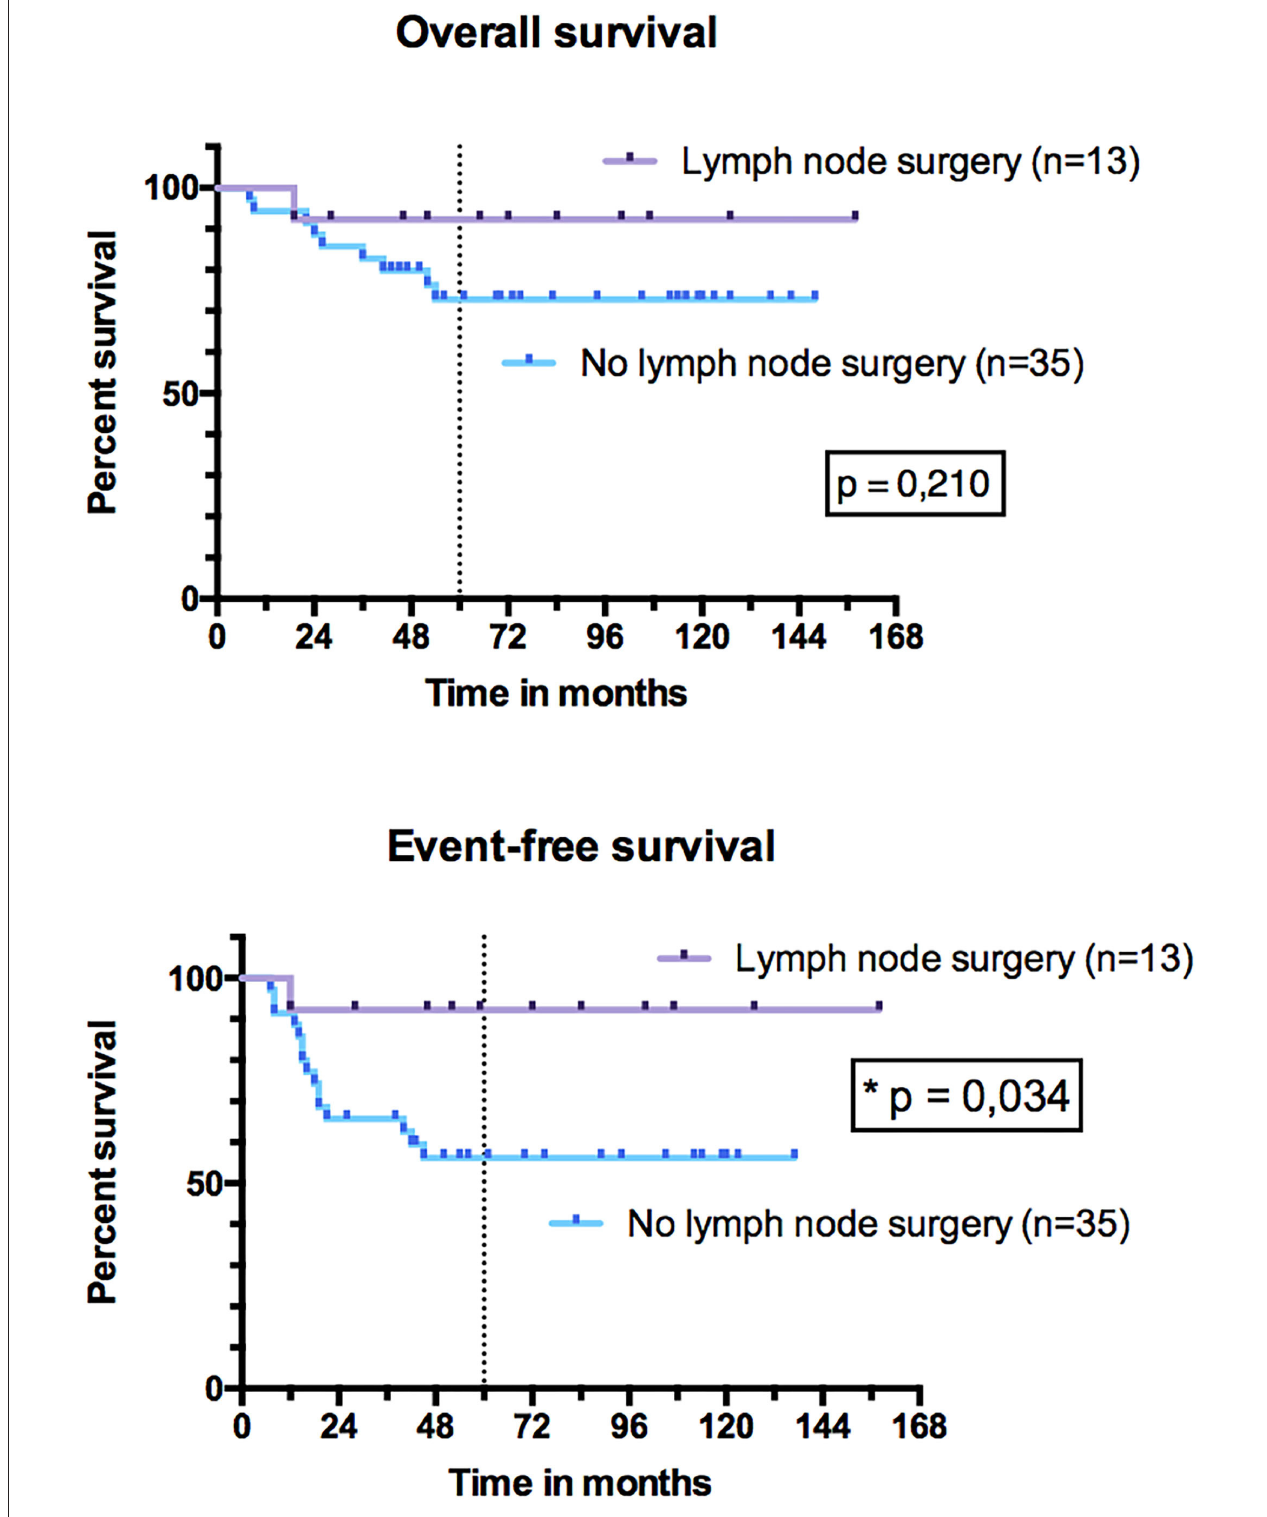
FIGURE 10 | Overall survival and event-free survival of patients with head and neck alveolar rhabdomyosarcoma (HN-ARMS) who underwent a lymph node dissection compared to those who did not.